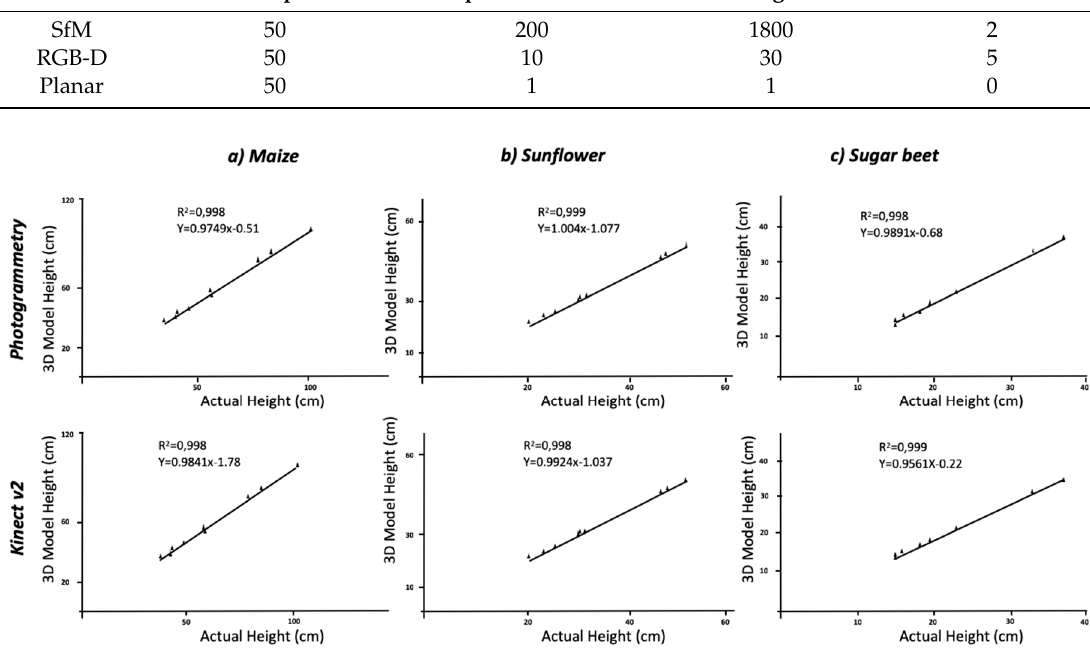
Figure 3. Regression analyses comparing actual plant height versus estimated height using 3D modeling methods.